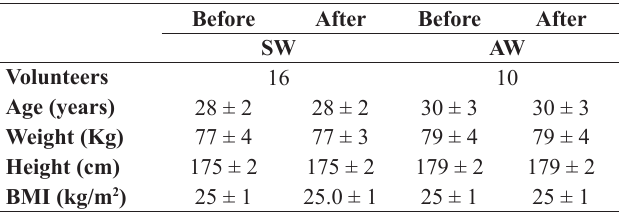
Table 1. Demographic characteristics before and after the 6-month stretch break